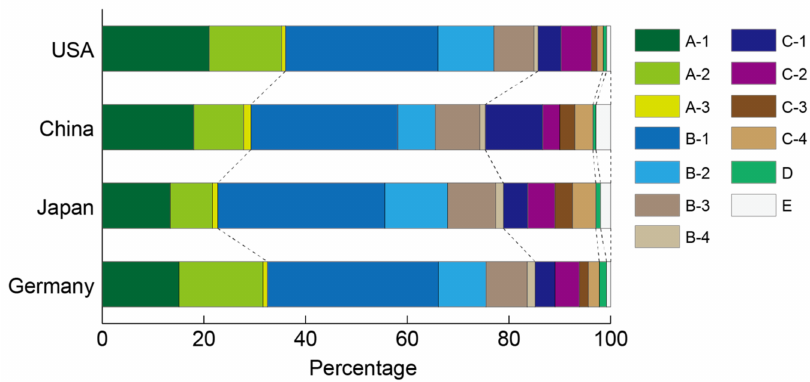
Figure 7. Research area population by representative countries for zeolites.